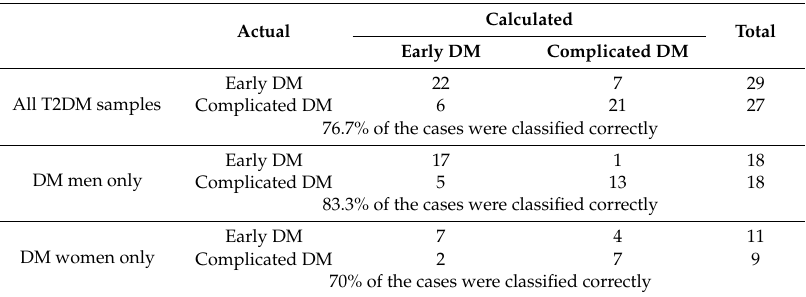
Table 1. Discriminant analysis of plasma levels of miR-146a-5p, miR-16-2-3p, miR-126-5p, miR-30d, and miR-423 in distinguishing early vs. complicated diabetes mellitus (DM). Calculated Actual Total Early DM Complicated DM Early DM 22 All T2DM samples